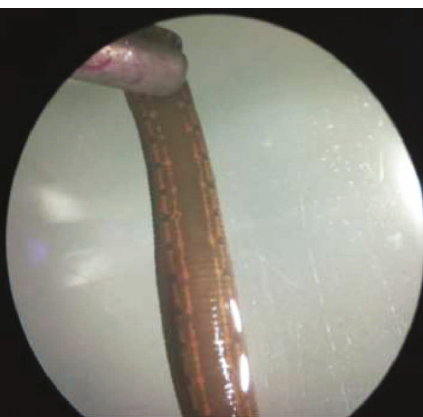
Figure 1: The morphological feature of the isolated leech as Hirudo orientalis .